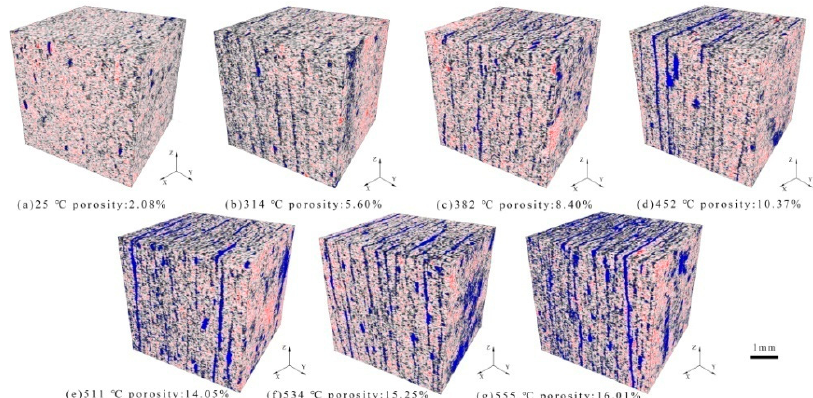
Figure 5. 3D volume-rendered digital cores of oil shale (DCOSs) (the pore space is shown in blue): ( a ) 25 °C porosity: 2.08%; ( b ) 314 °C porosity: 5.60%; ( c ) 382 °C porosity: 8.40%; ( d ) 452 °C porosity: 10.37%; ( e ) 511 °C porosity: 14.05%; ( f ) 534 °C porosity: 15.25%; ( g ) 555 °C porosity: 16.01%.